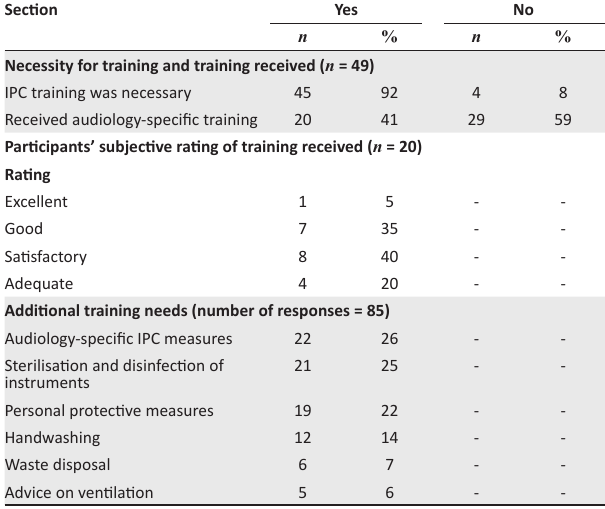
TABLE 3: Summary of the training the audiologists and speech therapists, and audiologists had received and additional training needs. Section